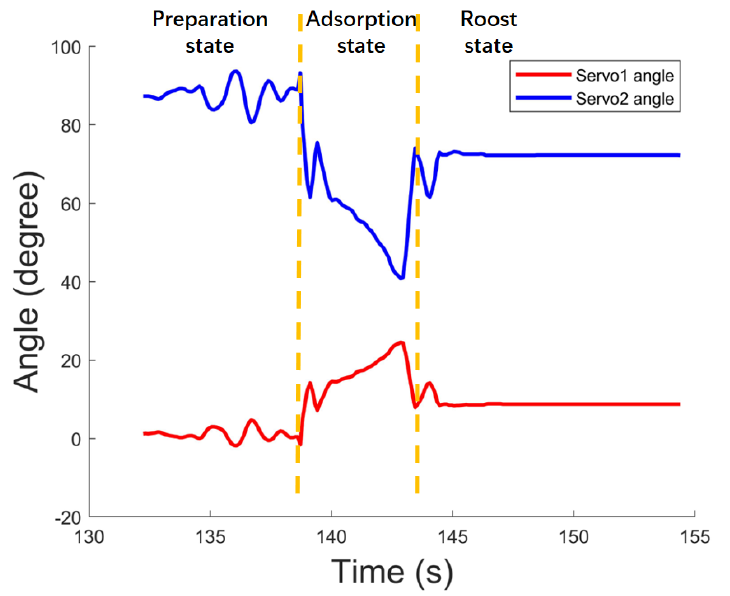
Figure 21. Servo angle curve of the robot. (The different working states are divided by the yellow dotted line). dotted line).